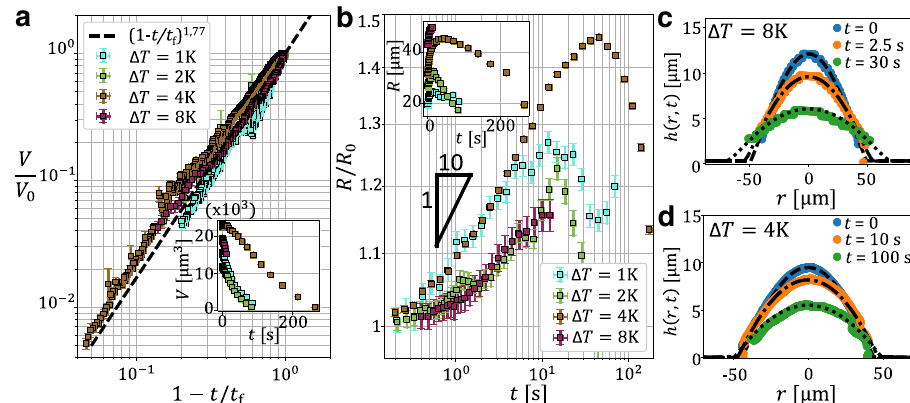
Fig.2|Rawdata:pro fi lesandmainobservables.a Rescaleddropletvolume V / V 0 as a function of the rescaled time 1 − t / t f , with V 0 the initial volumes and t f the evaporation times of all droplets, for four different distances to the critical tem- perature Δ T . The dashed line indicates the empirical power law ð 1 (cid:2) t = t f Þ 1 : 77 . Inset: corresponding raw data. b Contact radius, divided by its initial value R 0 , as a function of time for the same temperatures. The 1/10 power-law exponent of